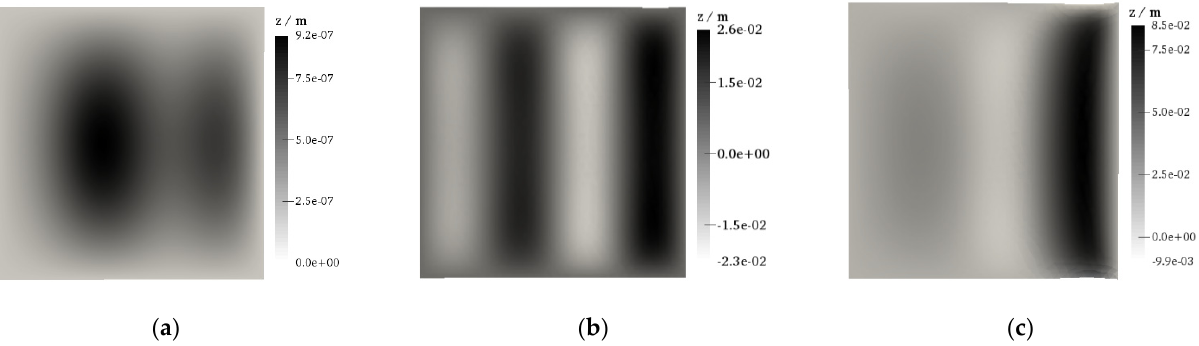
Figure 26. Z coordinates of nodes for strain rate 2.5 × 10 − 1 s − 1 and horizontal shortening of the plate of: ( a ) 10.0 mm; ( b ) 14.2 mm; and ( c ) 28.0 mm.